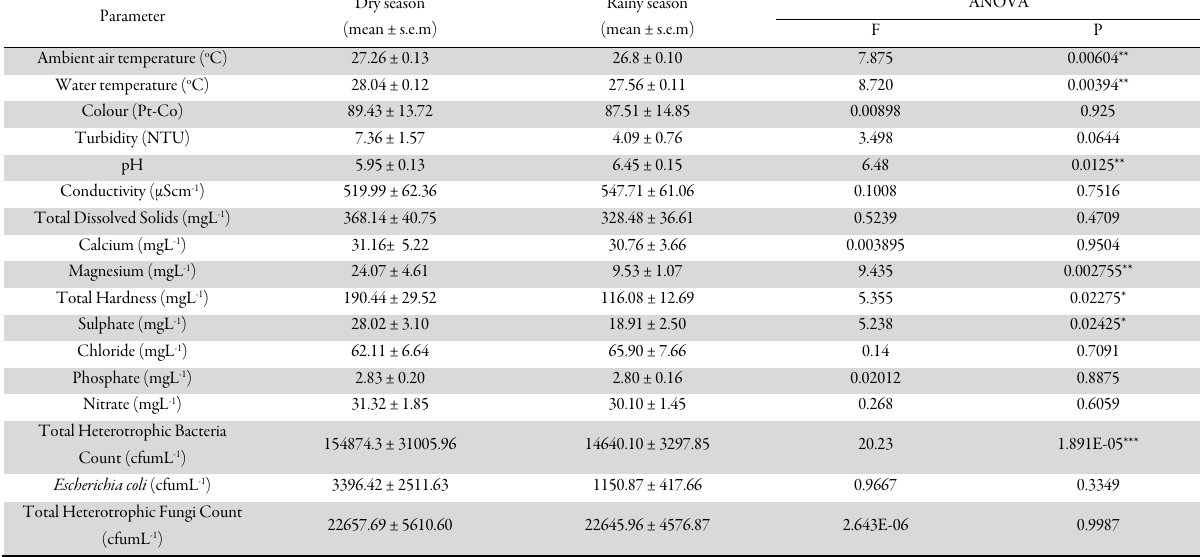
Table 2. Seasonal variations of selected hand-dug well water samples from Ilesa Metropolis